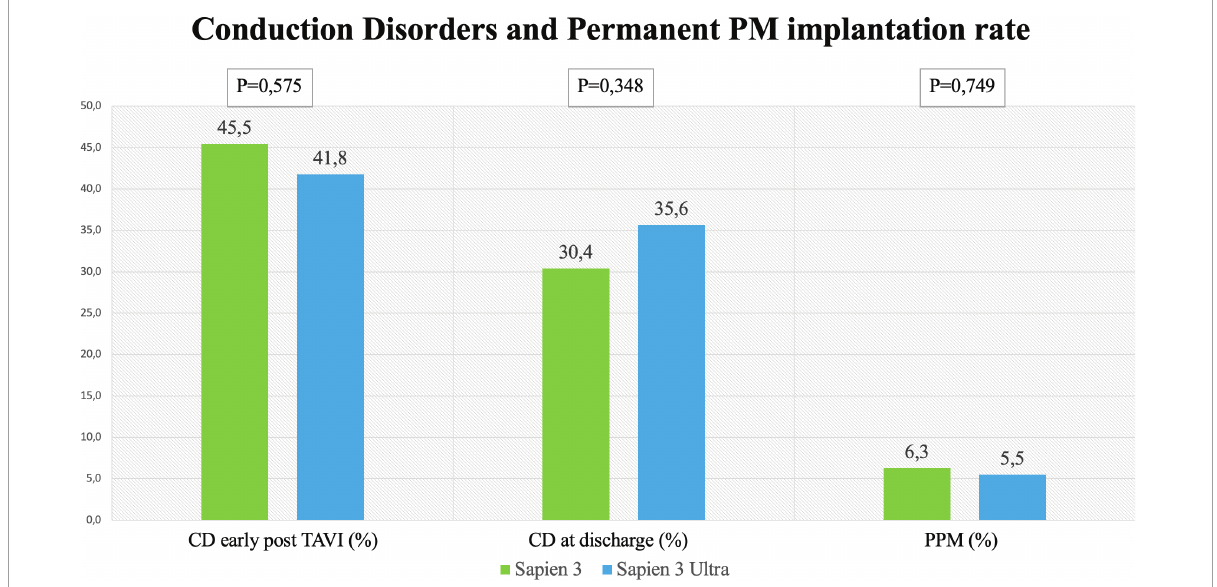
FIGURE2 Rates of conduction disorders (CD) Left and central panel shows CD early after the procedure and at discharge with the SAPIEN 3 and SAPIEN 3 Ultra. Right panel shows rate of permanent pacemaker (PPM) implantation after TAVI with the SAPIEN 3 and SAPIEN 3 Ultra.